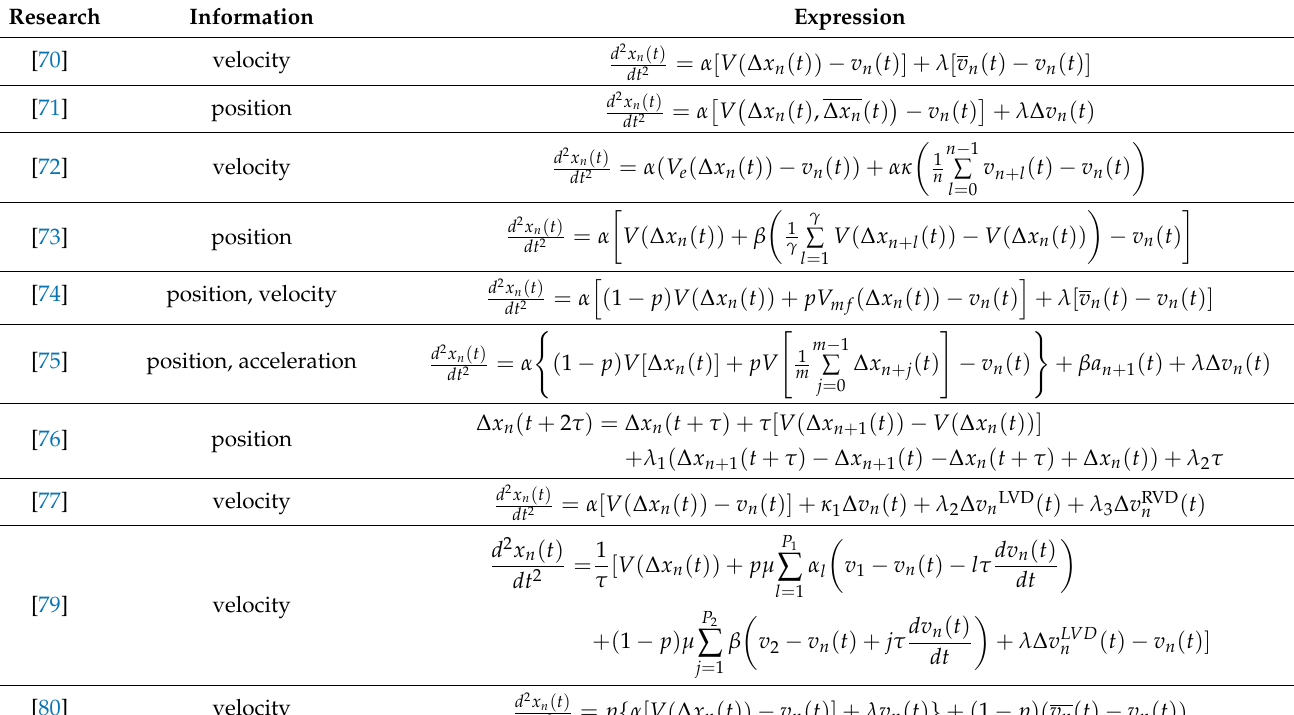
Table 3. Incorporated information in the above models and their